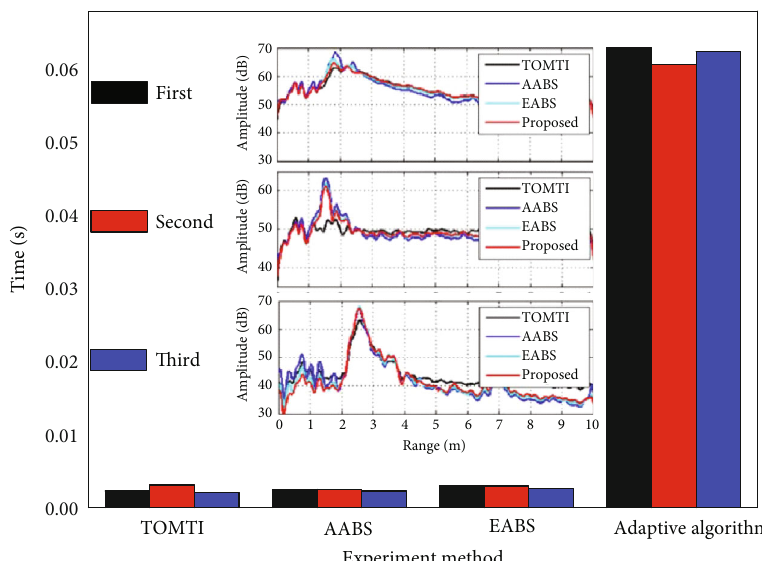
Figure 12: Consumed comparison time of processing 200 pulses in the 3 experiments (the data were obtained from Ref.